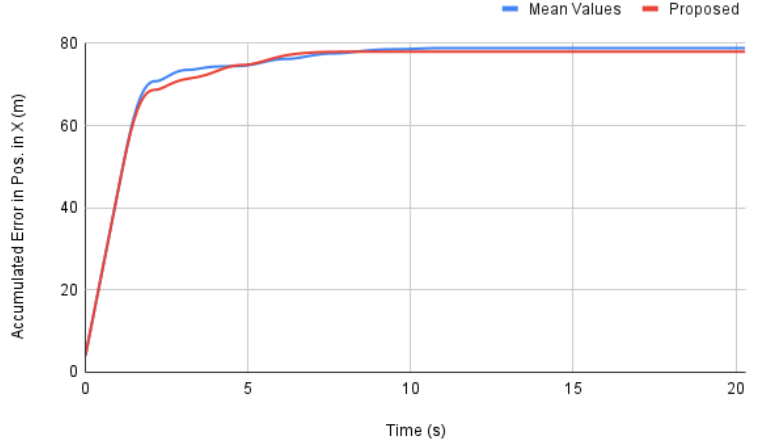
Figure 14. Accumulated Error comparison between the proposed method and using the mean values of the fuzzy logic gains.